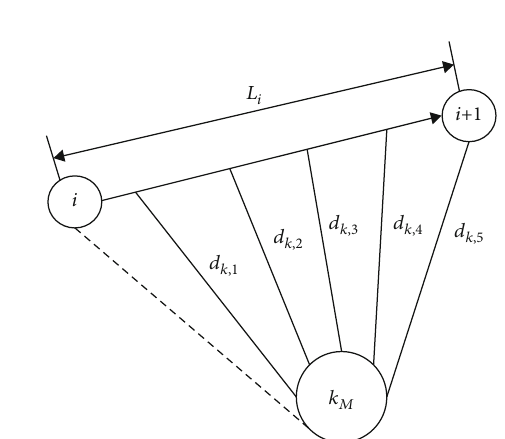
Figure 7: Comprehensive threat